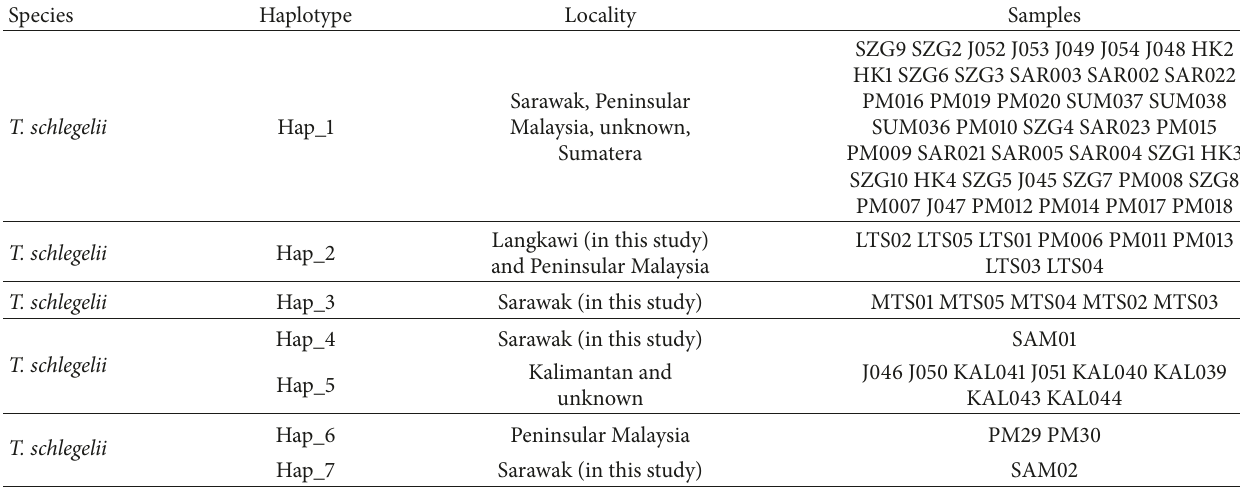
Table 3: Analyses of mtDNA Cyt b-CR gene sequences among T. schlegelii . Species Haplotype Locality